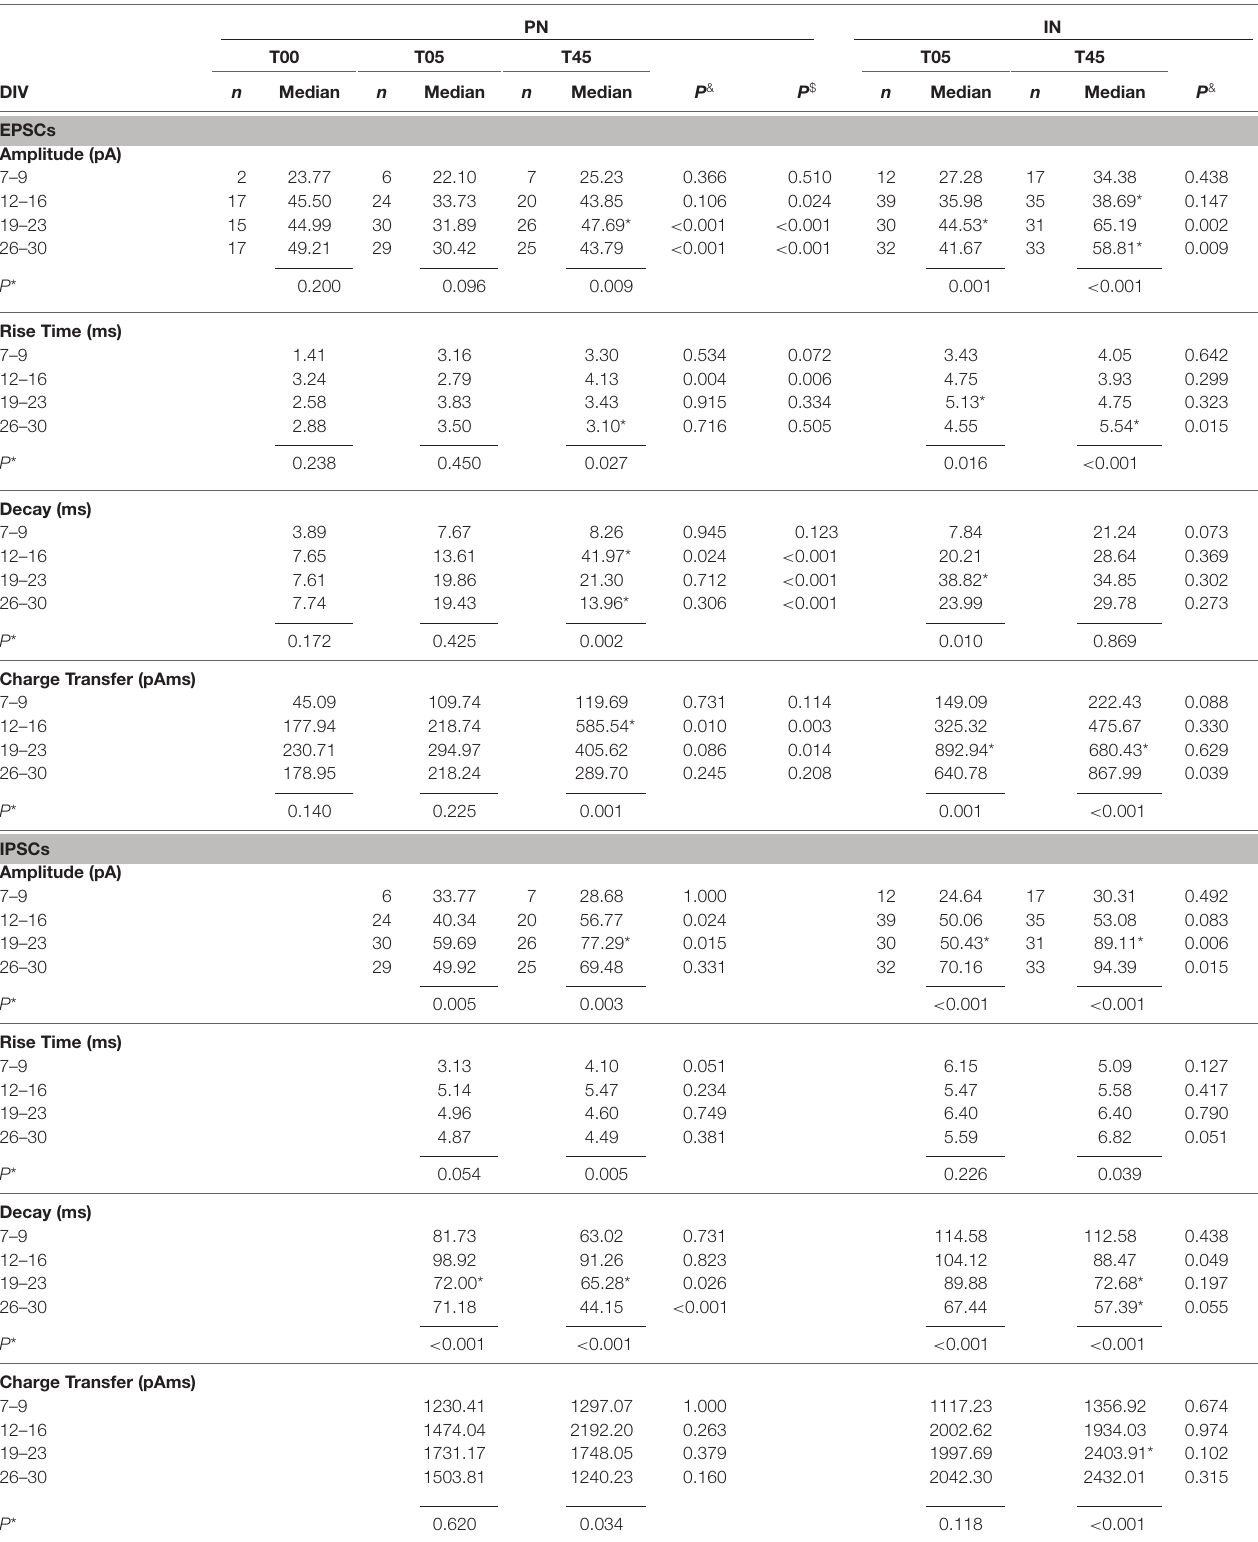
TABLE 2 | Summary of EPSCs and IPSCs parameters in Projection Neurons (PNs) and GABAergic Interneurons (INs) of T00, T05, and T45